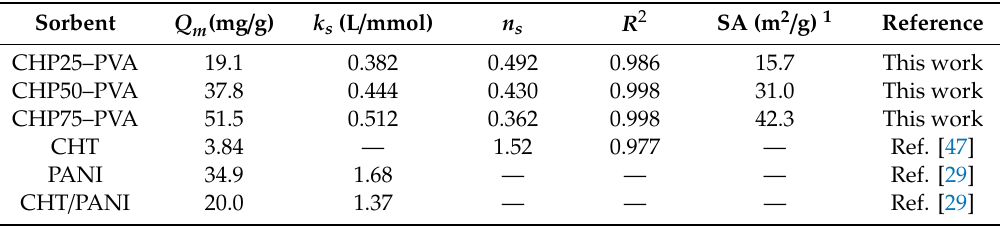
Table 2. Sips isotherm parameters: monolayer adsorption capacity ( Q m ) and accessible surface area (SA) for ternary / binary composites and single component materials. 1